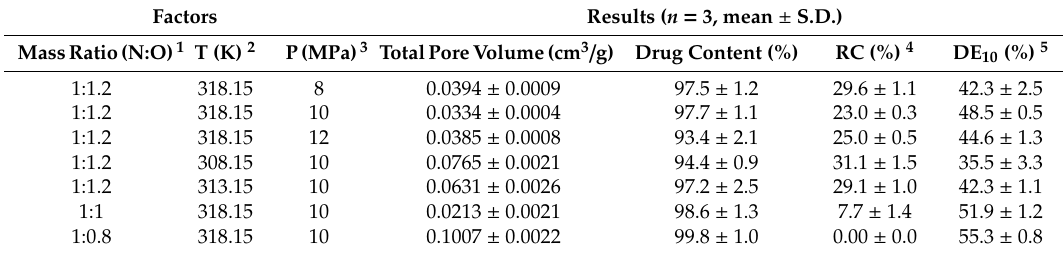
Table 3. Experimental conditions of the melt-amorphisation by supercritical fluid (MA-SCF) process. Factors Results ( n = 3, mean ±